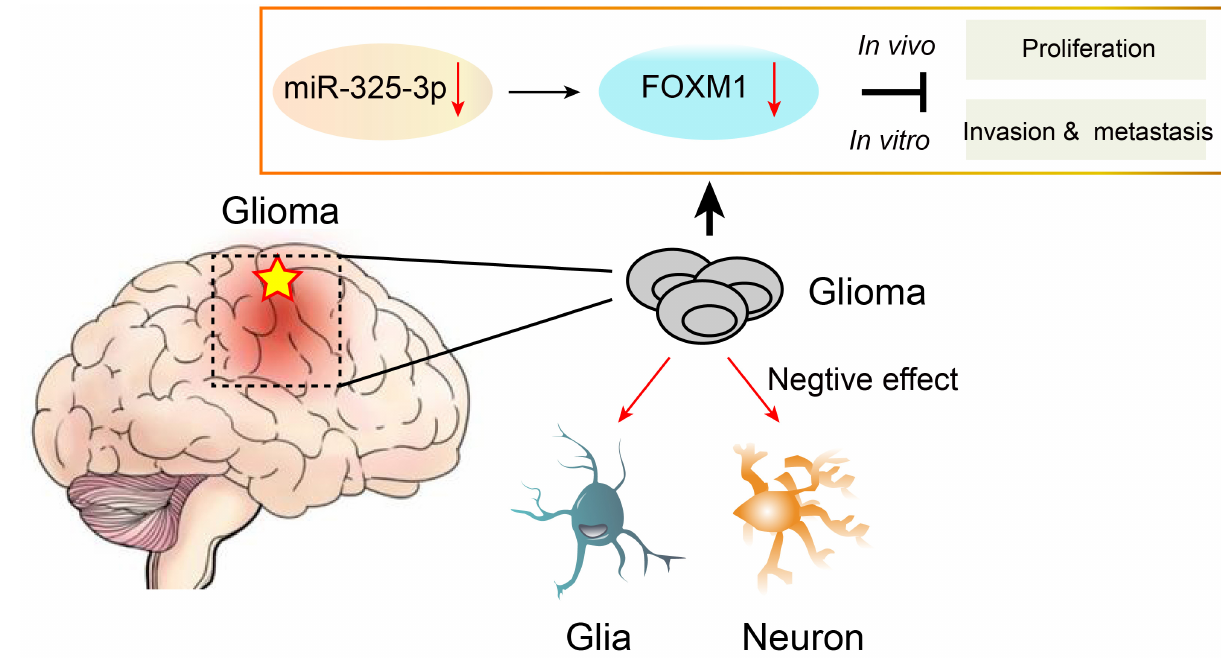
Fig. 1. Schematic illustration of rationale to show the intersections between neuroscience and glioma biology.